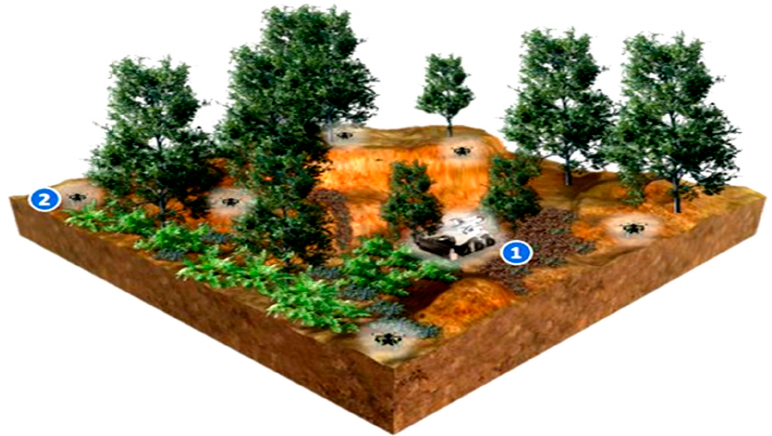
Figure 9. Deployment and work fl ow of Ranger-Scout multi-robot system.  Multi-purpose Ranger  Scouts (Figure from